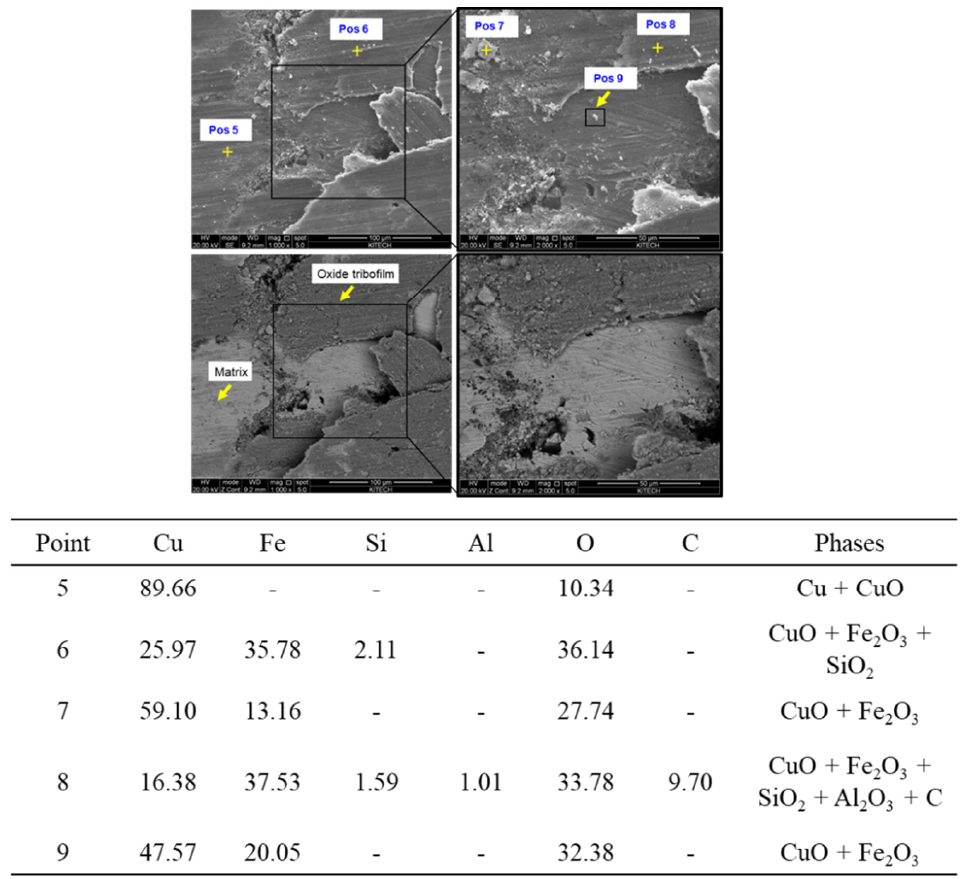
Figure 9. SEM and BSE images and EDS analysis results of worn surfaces of ( a ) 800-20 and ( b ) 800-40 samples after ball- on-disc test performed at 3 and 10 N.